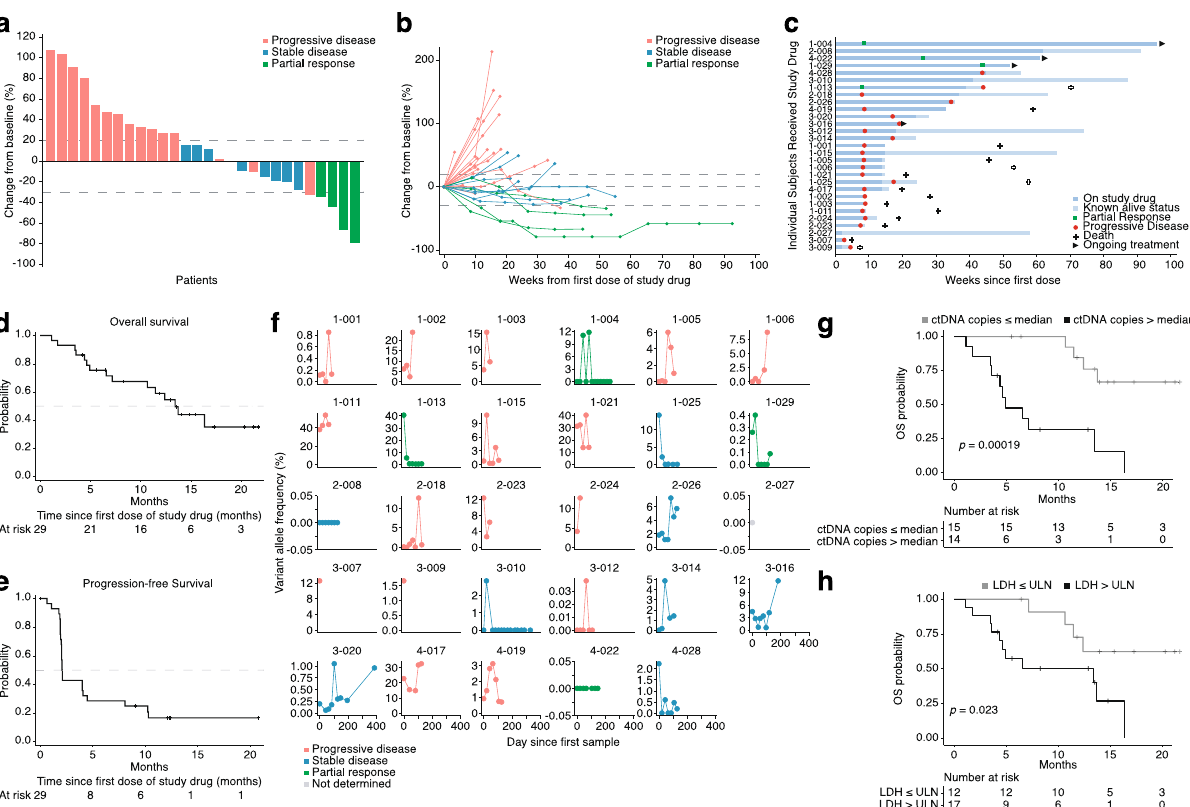
Fig. 1 Clinical outcome data from the PEMDAC trial at data cutoff in December 2019. a Waterfall plot showing maximum change in sum of target lesion diameter from baseline to data cutoff. One patient did not have a response assessment after baseline and is not included in the fi gure. Dotted lines represent thresholds for progressive disease ( + 20%) and partial response ( − 30%), respectively, according to RECIST v1.1 criteria. b Spider plot showing change in the sum of target lesion diameter over time for all patients with at least one follow-up scan. c Swimmer ’ s plot showing time on treatment, time to best response, and duration of response in all patients who received at least one dose of study drug. In panels (a,b), n = 28 and in (c) n = 29 patients are shown, respectively. d Kaplan – Meier analysis showing overall survival (OS) of all patients. e Kaplan – Meier analysis showing progression-free survival (PFS) of all patients except one. f Circulating tumor DNA levels in patients with UM. Plasma from twenty- fi ve patients was analyzed for the presence of mutated reads in either GNA11 (Q209L) or GNAQ (Q209L/P). Variant allele frequencies (VAF) in percent compared with reads with wildtype alleles are plotted. g Kaplan – Meier analysis comparing OS between patients with high or low (relative to median) levels of total detected ctDNA copies, n = 14 and n = 15 patients, respectively. h Kaplan – Meier analysis comparing OS between patients with lactate dehydrogenase (LDH) baseline greater or lower than the upper limit of normal (ULN), n = 17 and n = 12 patients, respectively. In ( g , h ), p -values for survival associations were calculated using log-rank tests. No adjustments for multiple comparisons were made. All statistical tests were two-sided. Source data are provided as a Source Data fi